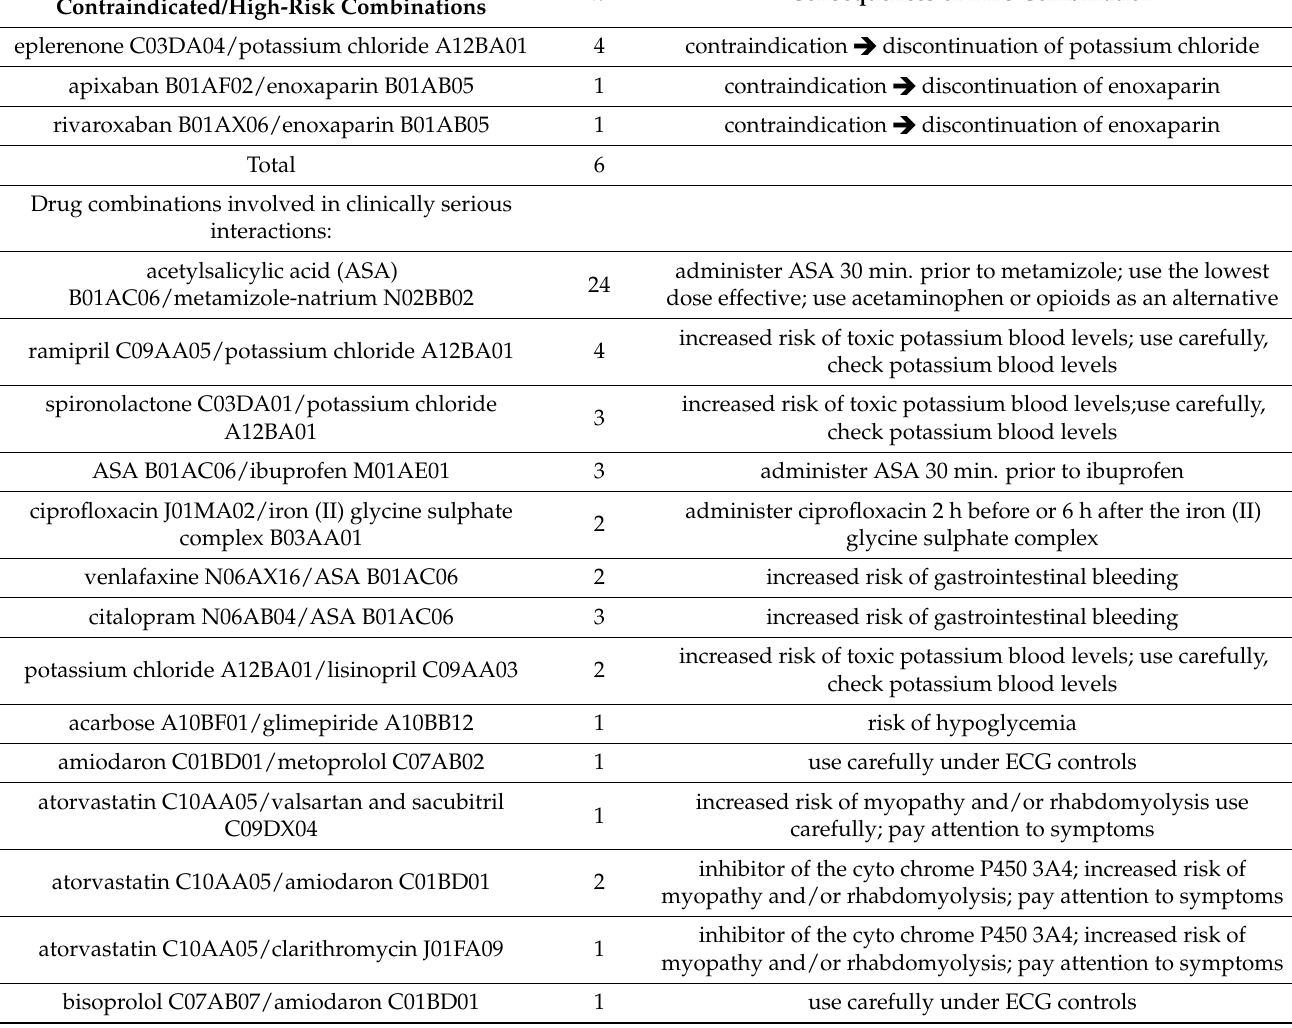
Table 2. Interactions based on the Anatomical Therapeutic Chemical Classification System (ATC).